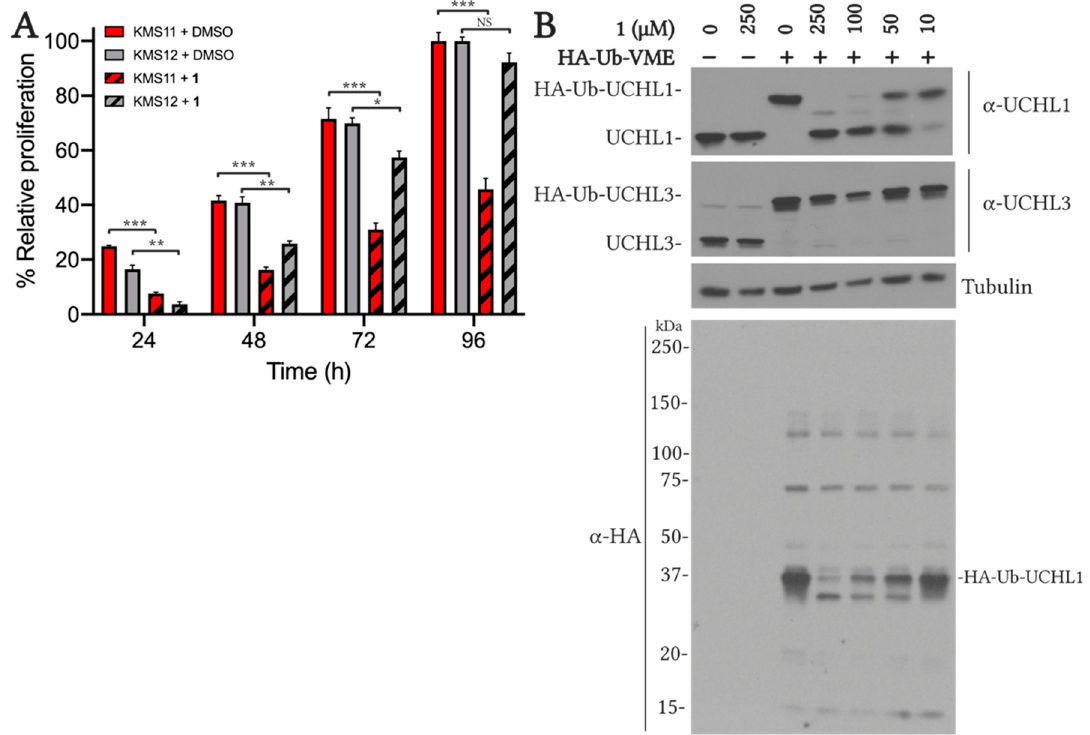
Figure 7. Cellular characterization of 1 in KMS11 and KMS12 myeloma cells. ( A ) Cellular proliferation data for KMS11 and KMS12 cells treated with 1 (100 µ M) or DMSO control at 24-, 48-, 72-, and 96-h timepoints. N = 3, *, p < 0.05; **, p < 0.01; ***, p < 0.001. Statistical significance calculated using student’s t -test ( B ) Immunoblots data for KMS11 cells treated with 1 (0–250 µ M) then reacted with HA-Ub-VME. Blotting for UCHL1 (top panel) indicates the molecular weight shift of the HA-Ub-UCHL1 complex in the control lane and the dose-dependent decrease of this complex formation in KMS11 cells. Blotting for UCHL3 (second panel from top) indicates formation of HA-Ub-UCHL3 complex at every dose. Blotting for HA (bottom panel) confirms only dose-dependent decrease of HA-Ub-UCHL1 complex formation and no dose-dependent decrease of any other DUB.